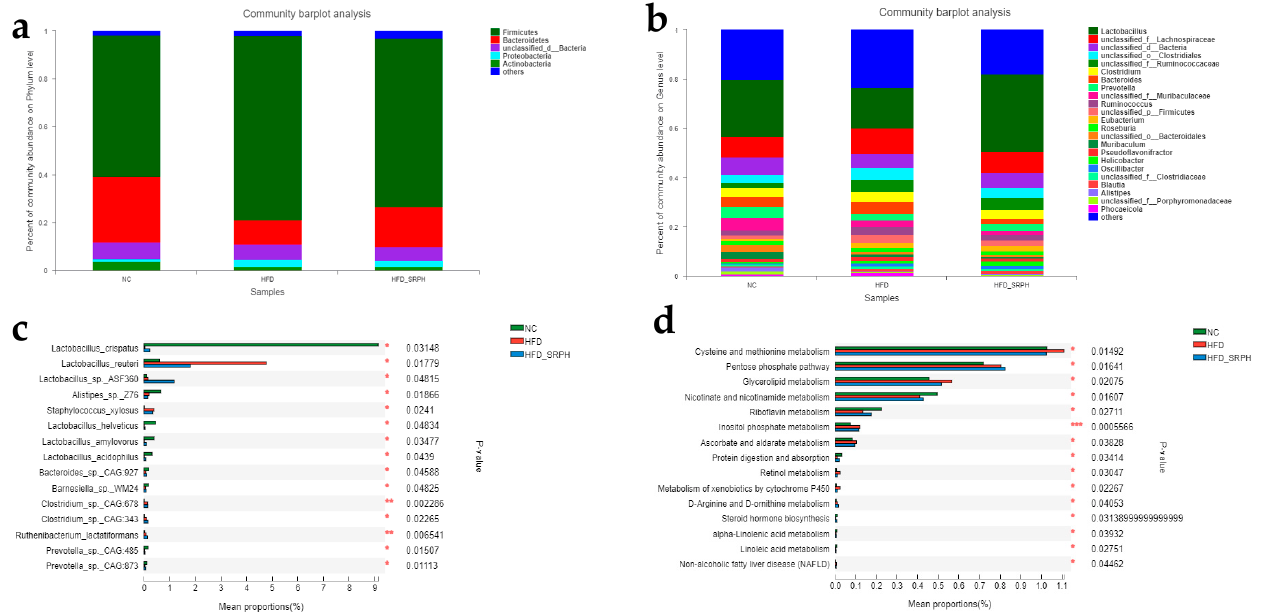
Figure 4. The fecal samples of NC, HFD, and HFD-SRPH groups were analyzed according to composition and function. ( a ) Relative abundance of taxonomic species at the levels of phylum. ( b ) Relative abundance of taxonomic species at the levels of genus. ( c ) Relative abundance of taxonomic species at the level of species. ( d ) Gut microbial function in HFD-fed mice. * p < 0.05, ** p < 0.01, *** p < 0.001.